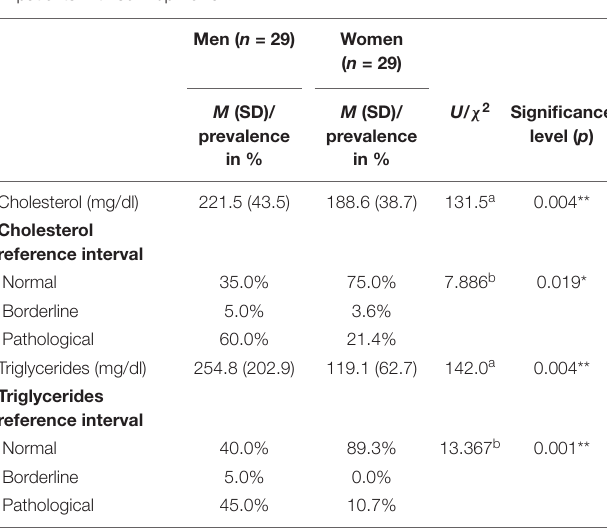
TABLE 4 | Differences in blood serum lipids between male and female forensic in-patients with schizophrenia.